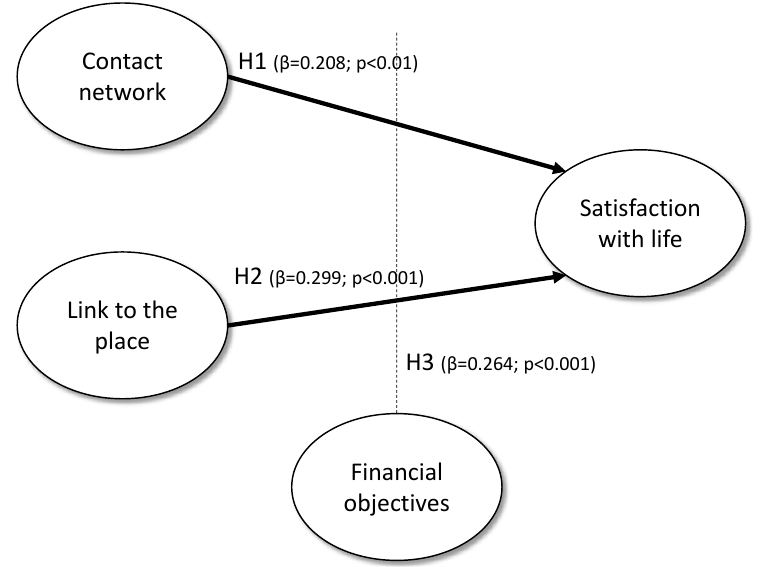
Figure 2. Conceptual model with the results.